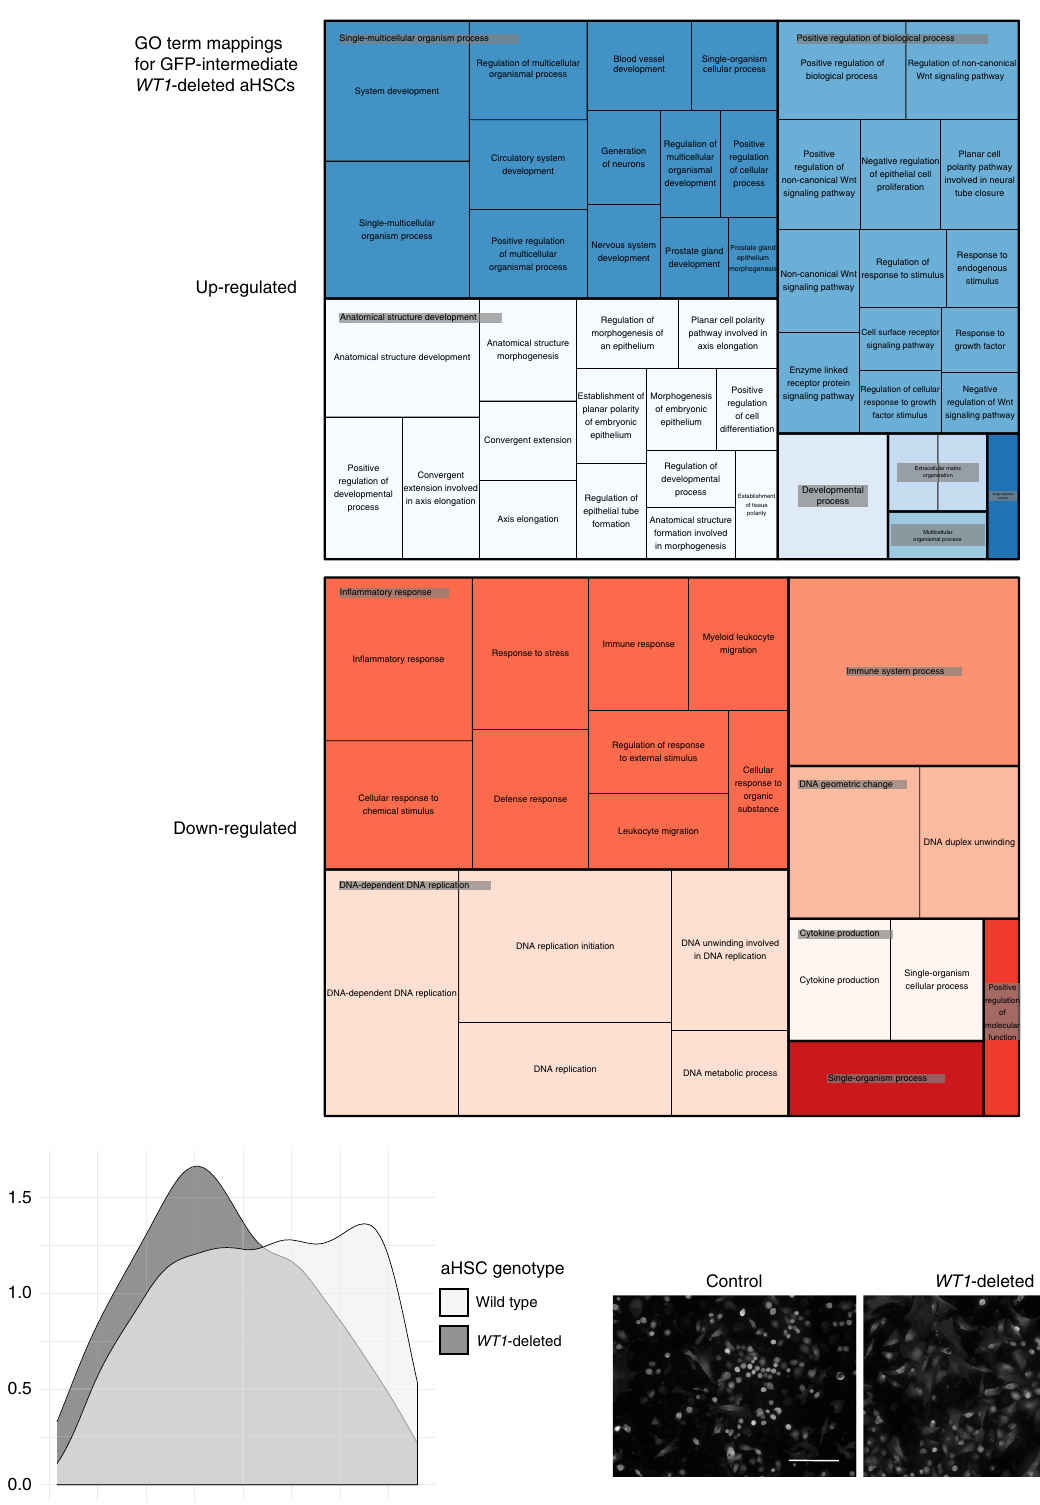
and WT1-positive scar-orchestrating cells in all models